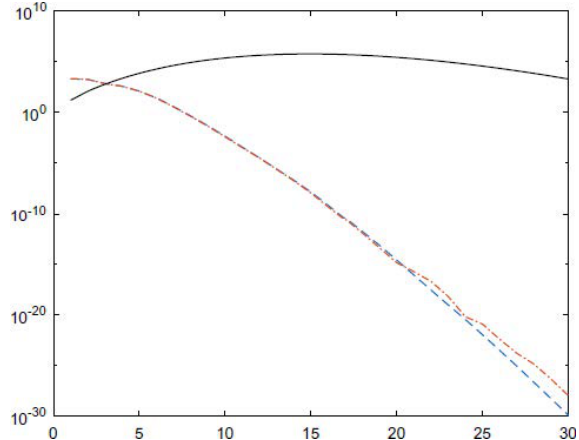
Fig. 8 Comparison curve between the algorithm in this paper and the conventional PSE-Tustin method. PSE, power series